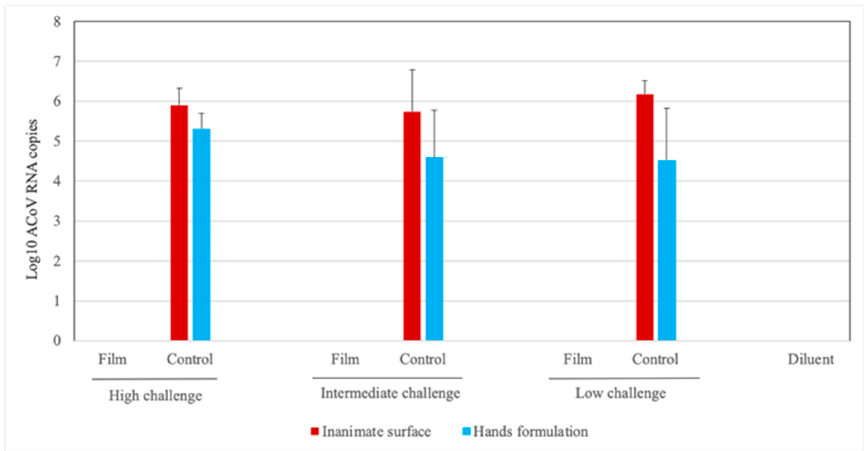
Figure 1. Absolute quantification of Log 10 avian coronavirus (ACoV) RNA copies (only positive samples presenting Cycle quantification (Cq) values < 36 were included) in the allantoic fluid from embryonated chicken eggs inoculated with virus suspension from different experimental groups previously treated or not treated with film and challenged with high, intermediate and low doses of ACoV. Table 2. Qualitative results of embryonated chicken eggs from different experimental groups obtained from avian coronavirus (ACoV) isolation and RT ‐ qPCR.